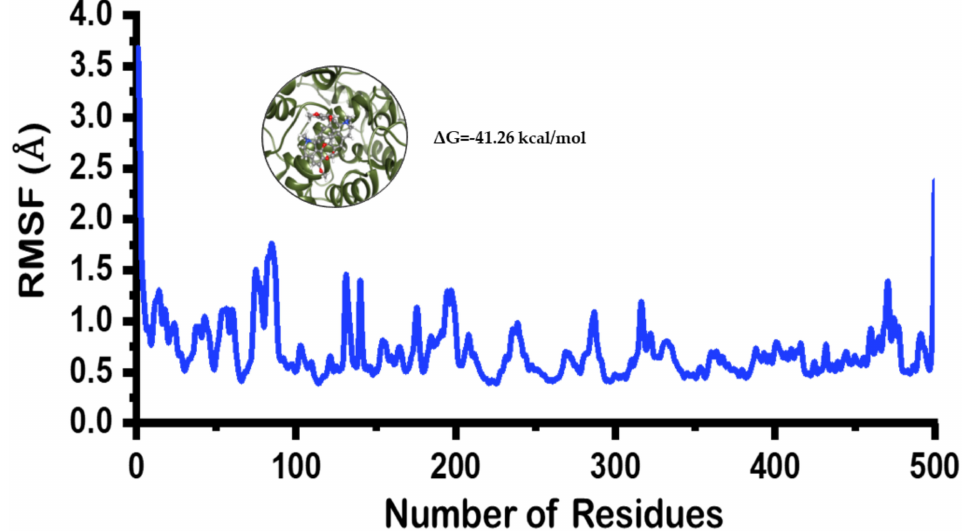
Figure 6. RMSF of the docked poses of limacusine. The x -axis is showing the total number of residues while the y -axis is showing RMSF in angstrom